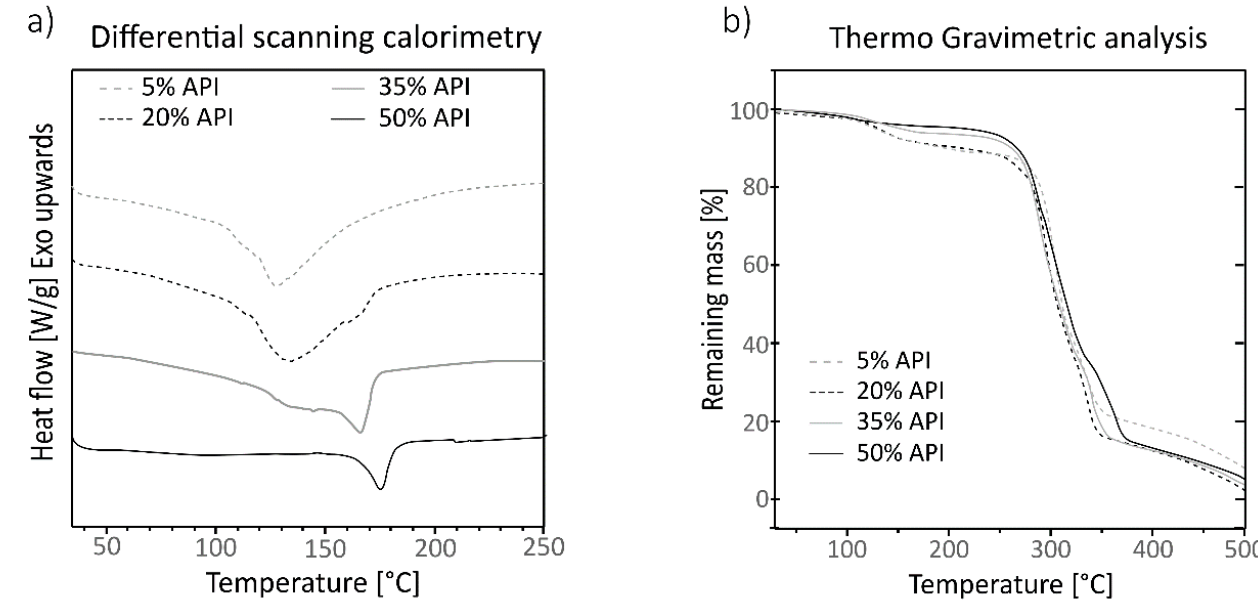
Figure 5. Differential Scanning Calorimetry ( a ) and Thermo Gravimetric Analysis ( b ) of samples containing 5%wt of Guar gum and different proportions of paracetamol, 5%wt dotted grey line, 20%wt dotted black line, 35%wt solid grey line and 50%wt solid black line. The horizontal axis represents the temperature in °C and the vertical axis the heat flow in (W/g) for the graph in the left panel and the percentage of remaining mass (%) in the right panel.